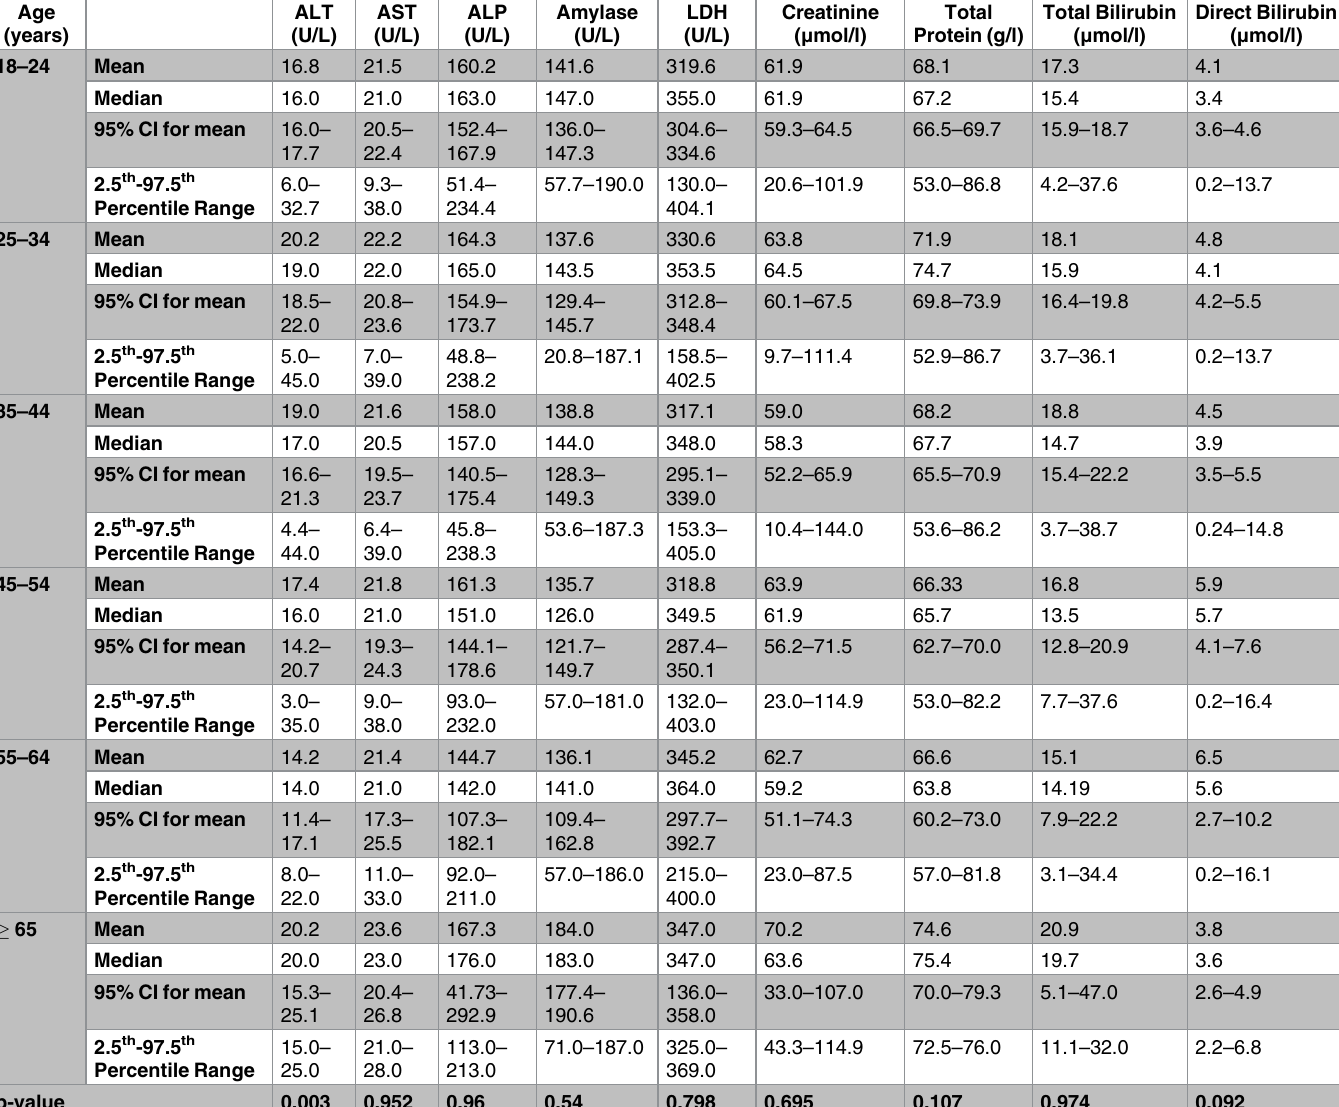
Table 3. Mean, median, 95% CI for mean and 2.5 th -97.5 th percentile of clinical chemistry referencevalues in relation to age profile of healthy adults in Gojjam, Zones, AmahraNational Regional State,Northwest